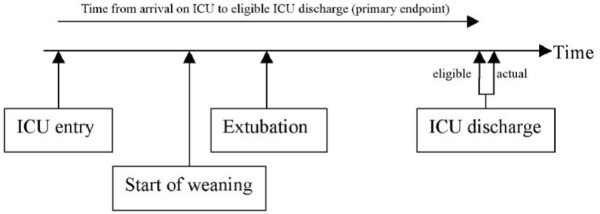
Recorded time points from arrival on the intensive care unit to discharge.